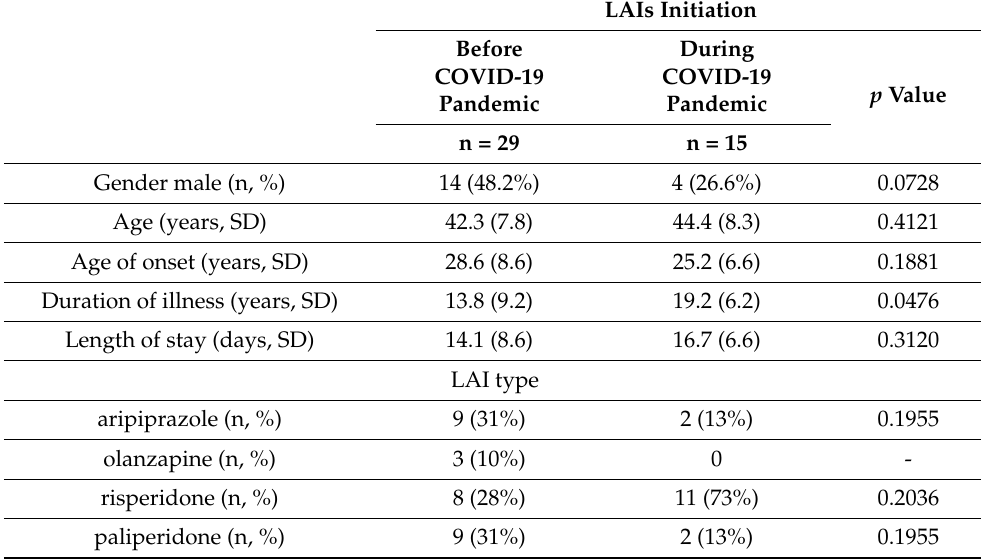
Table 2. LAIs initiation before and during COVID-19